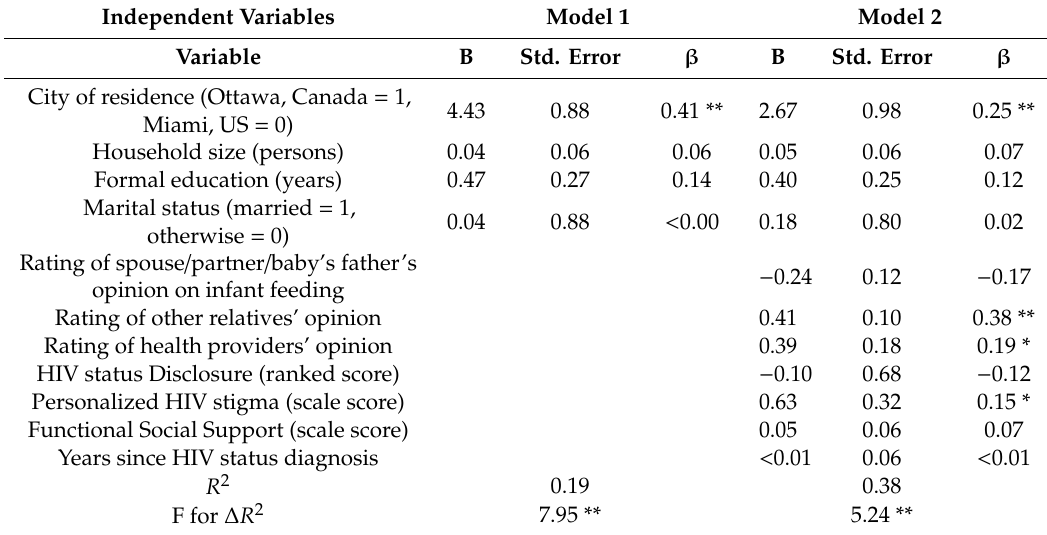
Table 3. Summary of hierarchical linear regression predicting breastfeeding